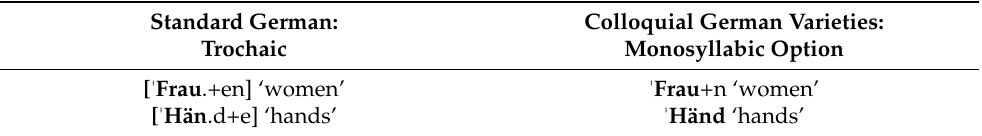
Table 2. Standard German with trochee requirement versus optional schwa in colloquial German varieties (in orthographic form). Please note that in both varieties, the second example obtains an umlaut in the plural. (Trochees marked as [ " syllable1. syllable2].) Standard